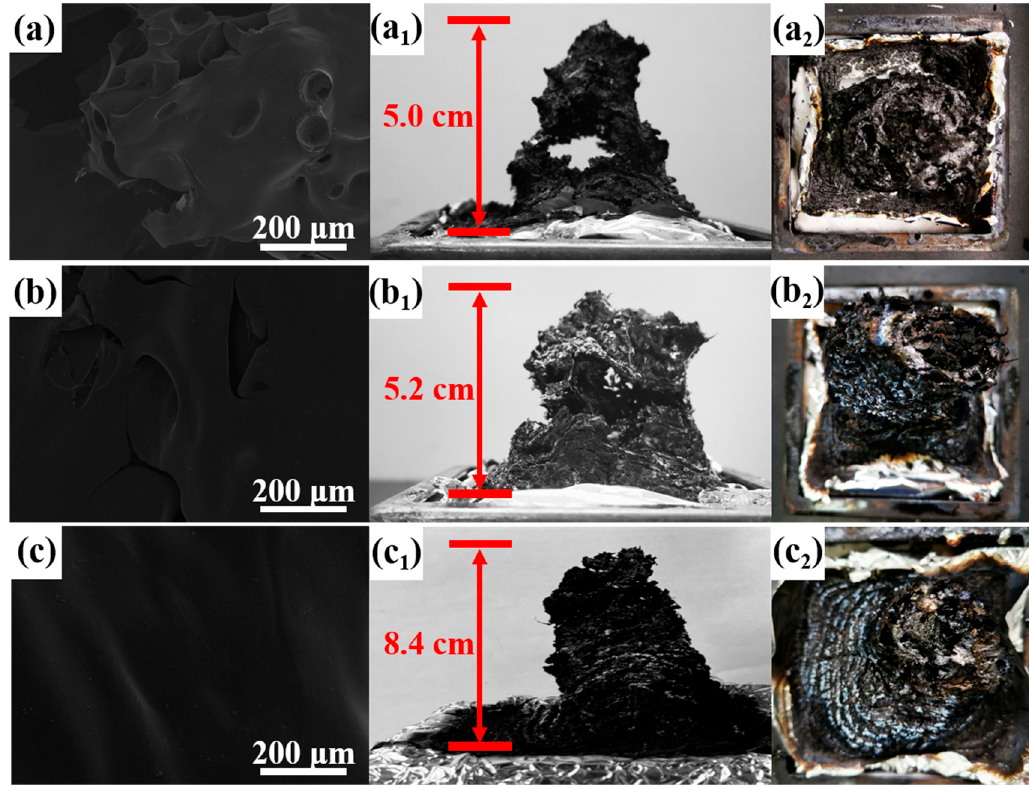
Figure 4. SEM (×200) and Digital images of PC ( a ), FRPC-1 ( b ) and FRPC-2 ( c ); Subscript 1, 2 represent the side and top surface.